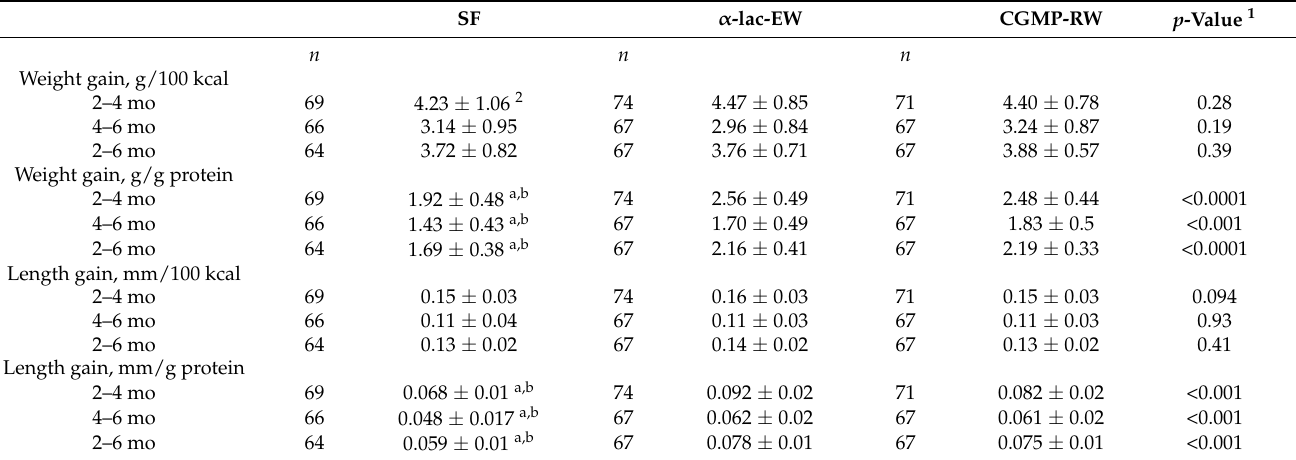
Table 6. Energy efficiency in infants fed formula (SF, α -lac-EW or CGMP-RW) * during the interven- tion, ITT population. α -lac-EW